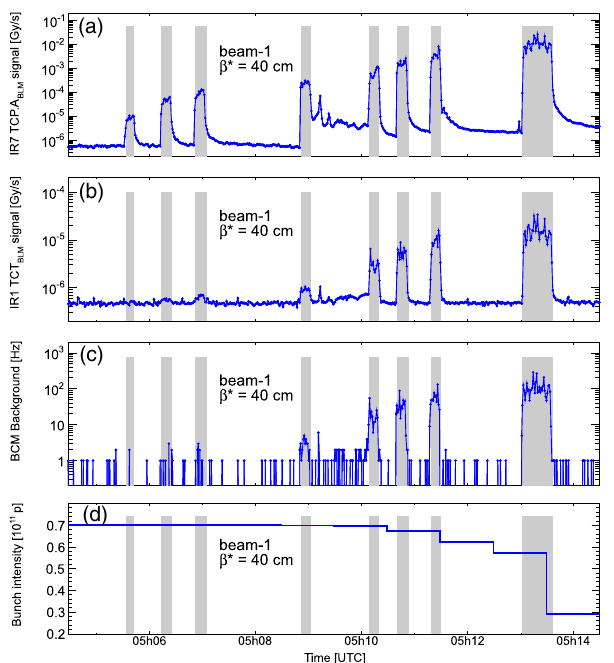
FIG. 3. Various observables during consecutive vertical exci- tations of a nominal bunch in B1 at β (cid:1) ¼ 40 cm with the TCT at 8 . 8 σ . The uppermost plot shows the TCP.A BLM signal, the second plot from the top shows the sum of the BLM signals at IR1 TCTH and TCTV, the third plot shows the measured BCM background in ATLAS from Ref. [24], and the bottom plot the intensity of the affected bunch. The shaded areas indicate the time limits of the excitations.